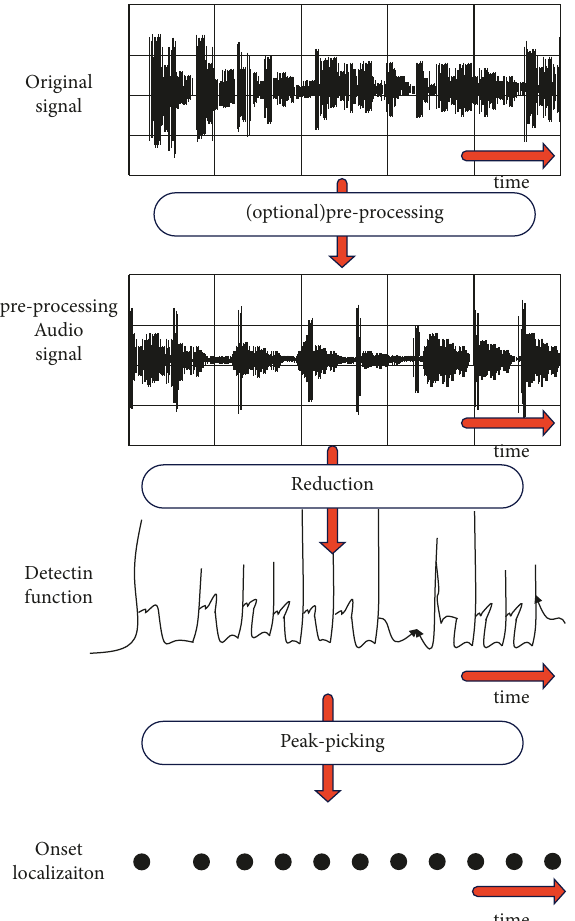
Figure 11: Steps for general shock